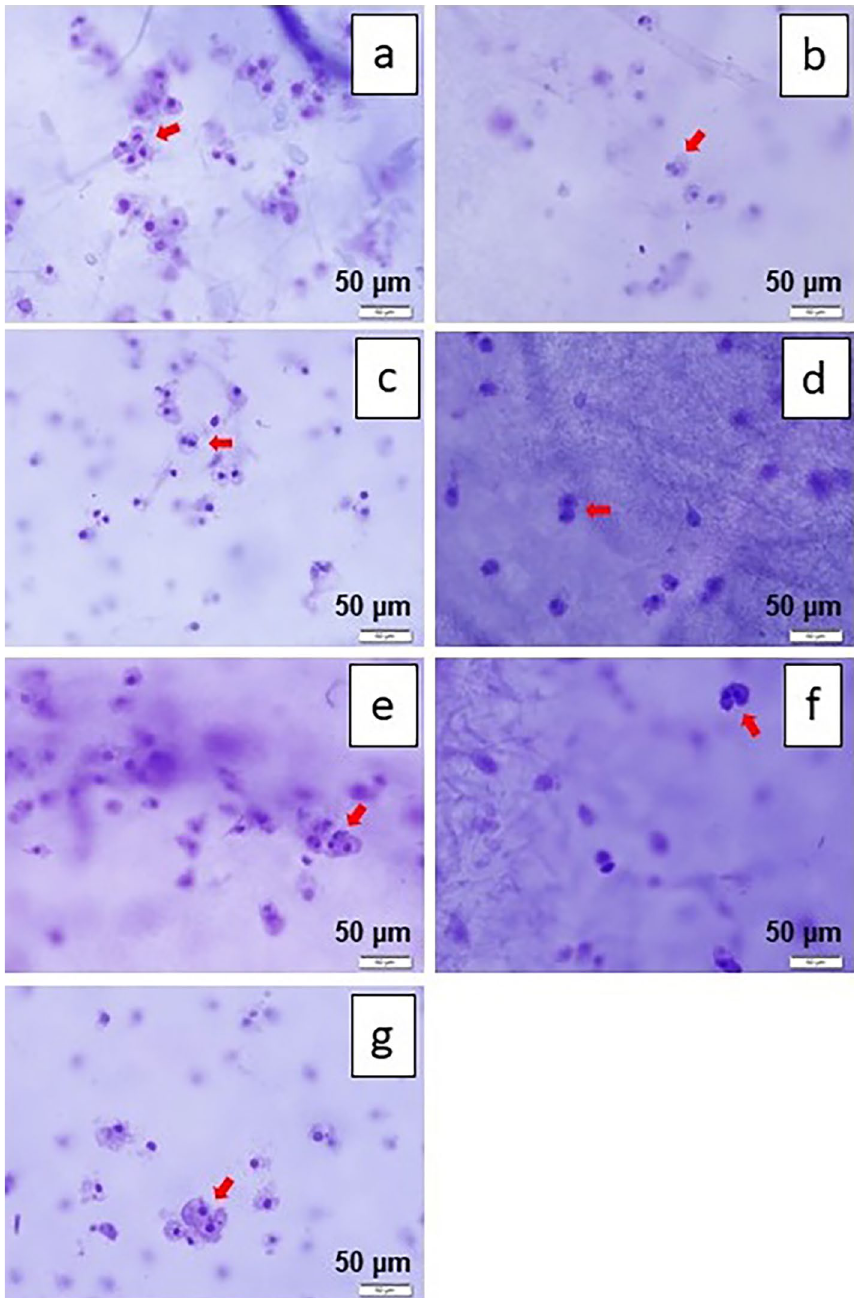
Figure 6. Cell formation and division on the fabricated nanofiber mats with SS/SF concentration (%w/v) ratio of ( a ) 0.0:0.0 ( b ) 2.5:2.5 ( c ) 3.0:2.0 ( d ) 3.5:1.5 ( e ) 4.0:1.0 ( f ) 4.5:0.5 ( g ) 5.0:0.0 with scale bar of 50